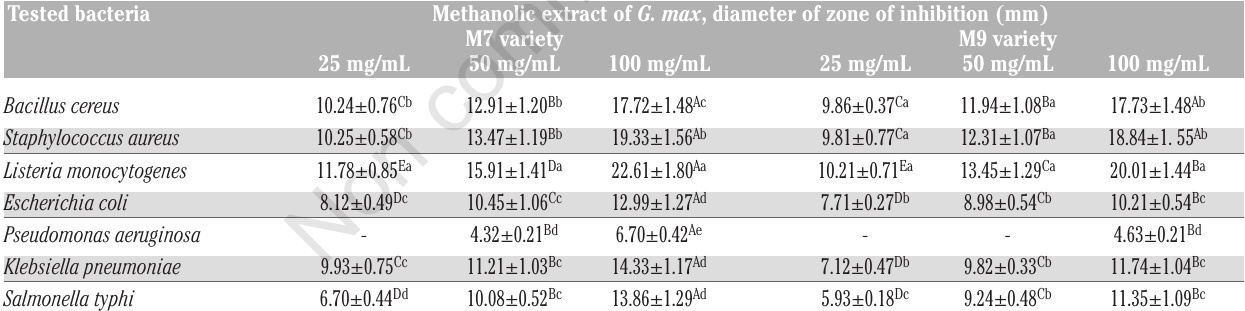
Table 1. Diameter of the zone of inhibition of different bacteria against methanoplic extract of G. max . Tested bacteria